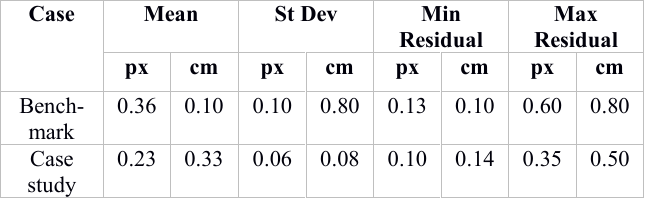
Table 2. Mean, Standard Deviation, Min and Max values of residuals for the Tour Saint Jacques compared with the tilting benchmark.